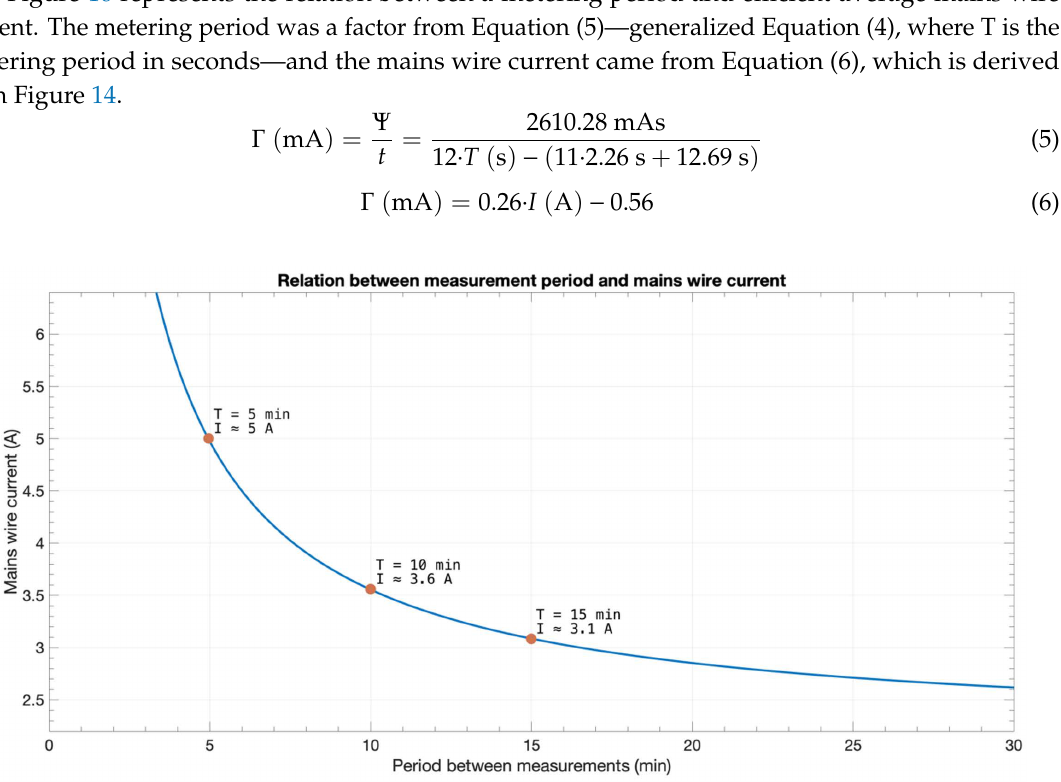
Figure 16. E ff ective average current needed in the mains wire vs. metering Figure 16. Effective average current needed in the mains wire vs. metering period.